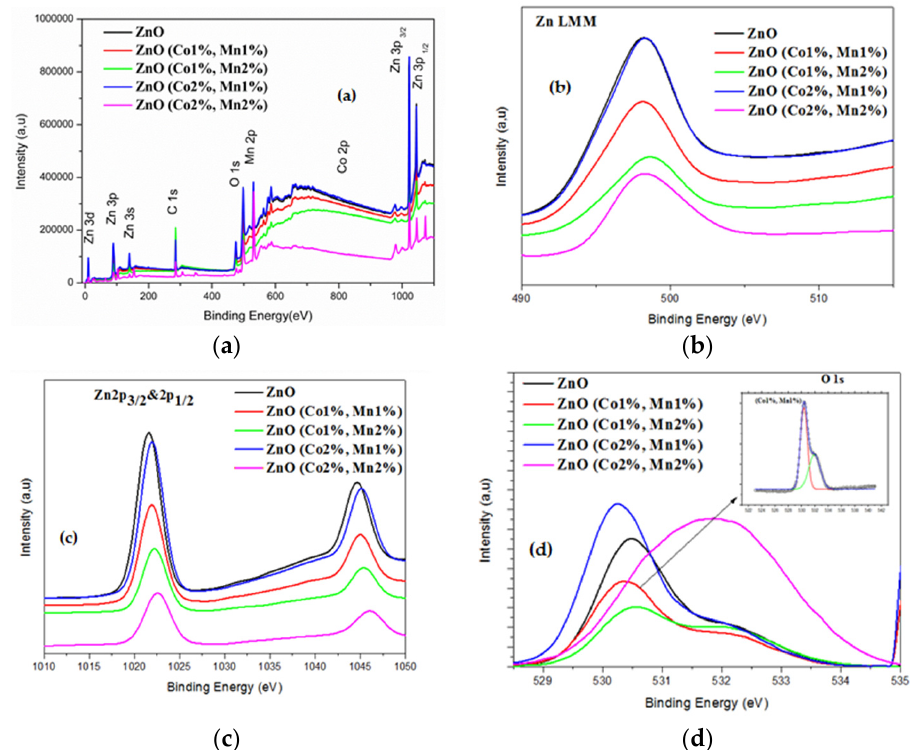
Figure 2. X-ray photoelectron spectroscopy (XPS) spectra of ( a ) the ZnO and (Co, Mn) co-doped ZnO; ( b ) the Zn LMM regions and ( c ) the Zn 2p3/2 and 2p1/2 regions; ( d ) the O 1s region of ZnO and (Co, Mn) co-doped ZnO (note: the XPS spectra were recorded at room temperature).